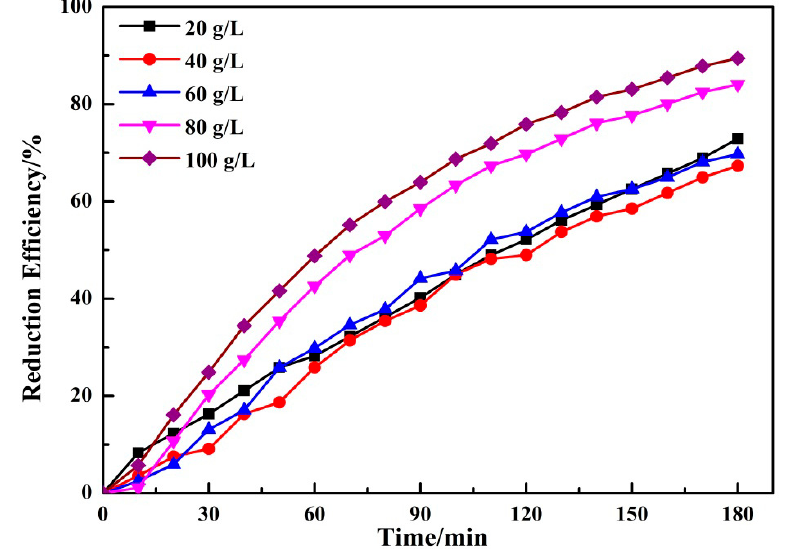
Figure 2. Effect of concentration of H 2 SO 4 on the reduction efficiency of chromium (VI).